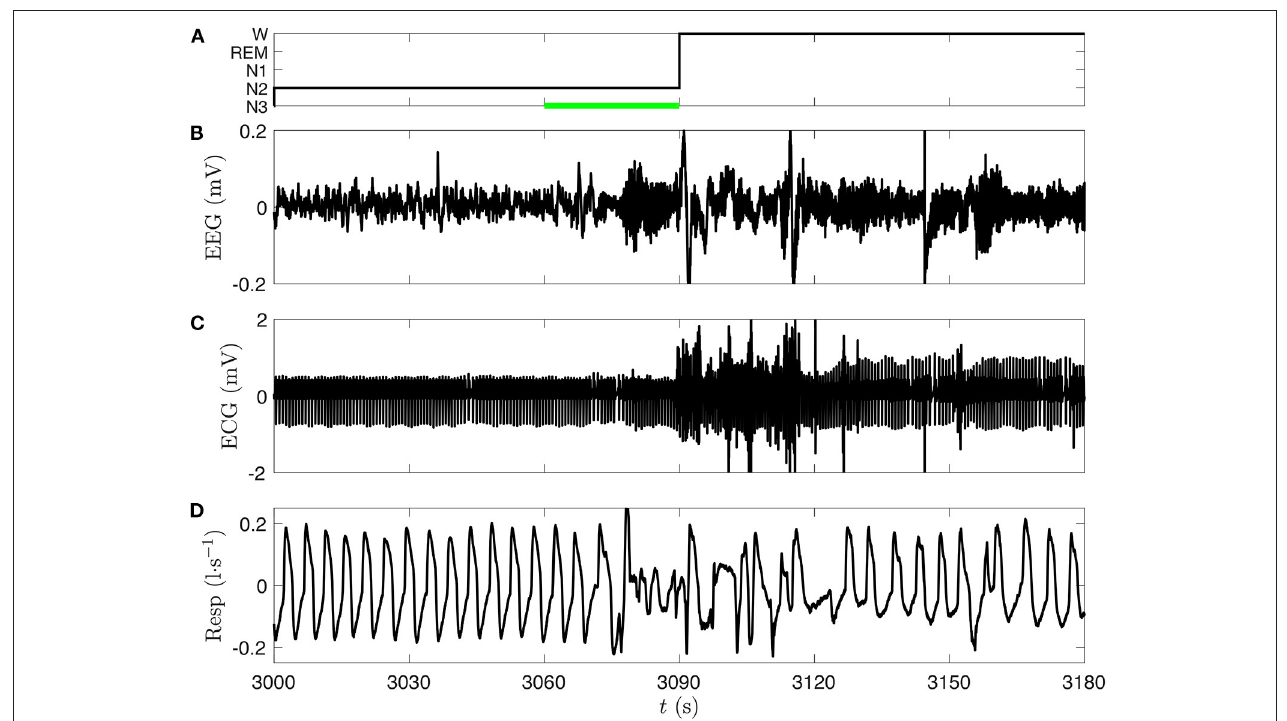
FIGURE 3 | Comparison of three polysomnographic signals of subject slp04 selected from the database slpdb . (A) Hypnogram of the person (black line), who is shifting from NREM sleep stage 2 (N2) to wake phase (W) between 3,060 and 3,090 s. Leg movements, which were annoted by the clinician in this 30 s epoch, are represented by a green bar. (B) EEG (C3-O1) in millivolt, (C) ECG in millivolt, and (D) nasal respiration in liter per